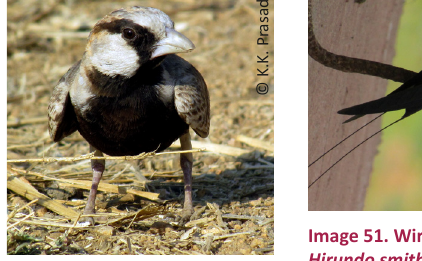
Image 53. Large Pied Wagtail Motacilla maderaspatensis